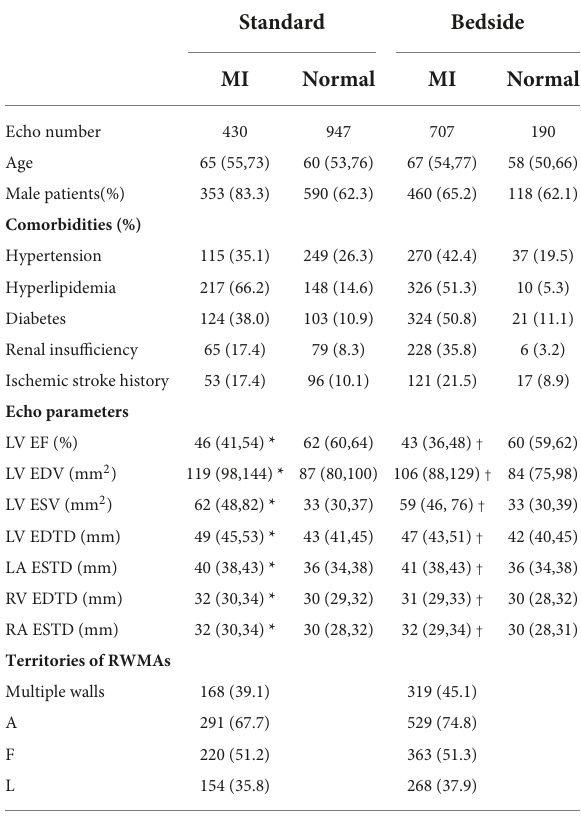
TABLE 1 Baseline characteristics of the training and validation